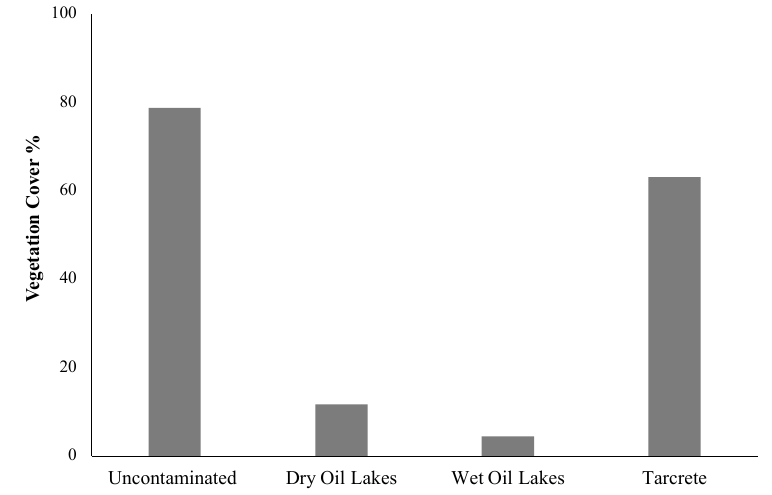
Figure 4. Vegetation cover distribution among three TPH-contaminated sites.